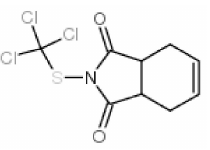
Figure 1. Chemical structure of captan